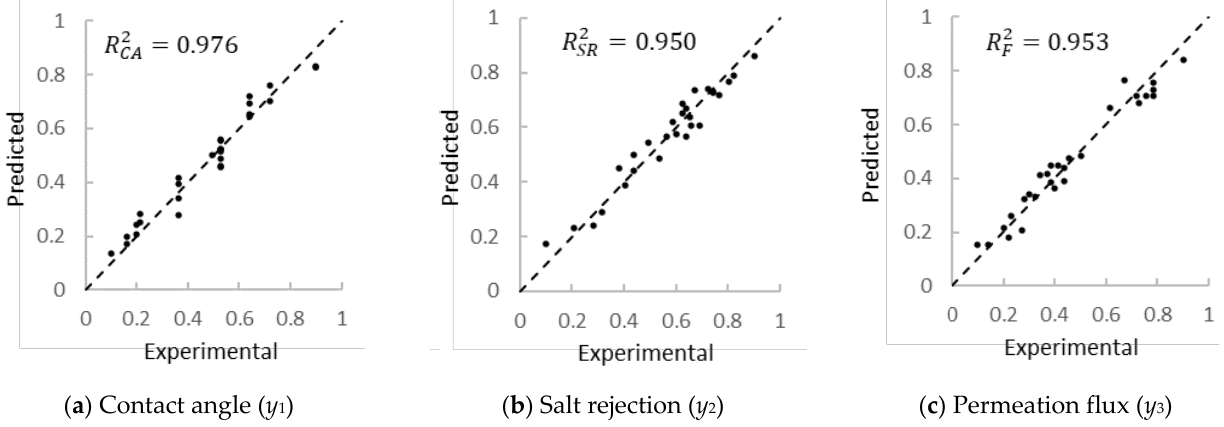
Figure 2. The goodness of fit tests for a three-layer ANN Model 3. Table 4. Correlation R between the input and output components.